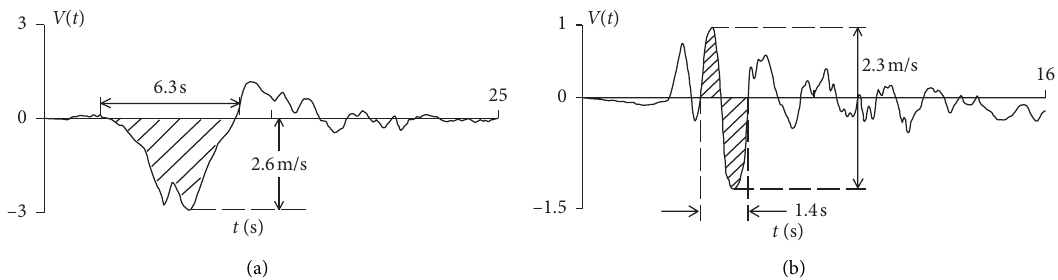
Figure 2: Typical velocity records of fling step and directivity pulse. (a) Fling step (Kobe earthquake, 1995). (b) Directivity pulse (Chi-Chi earthquake, 1999).